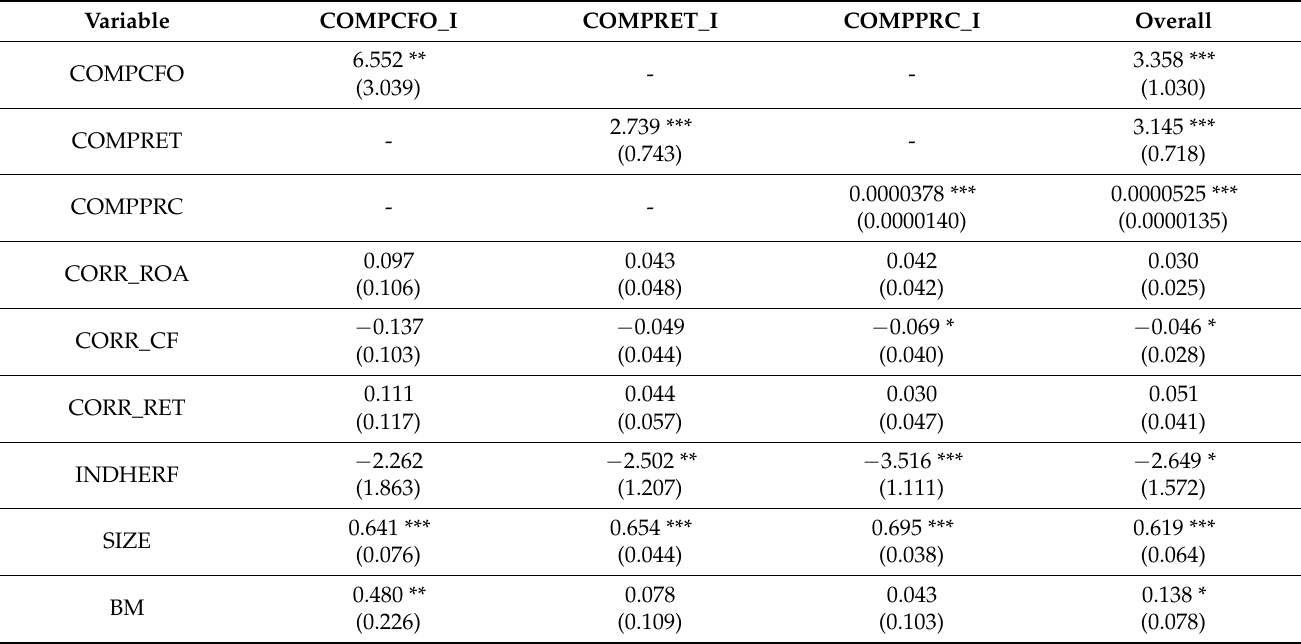
Table 3. Compensation and Accounting